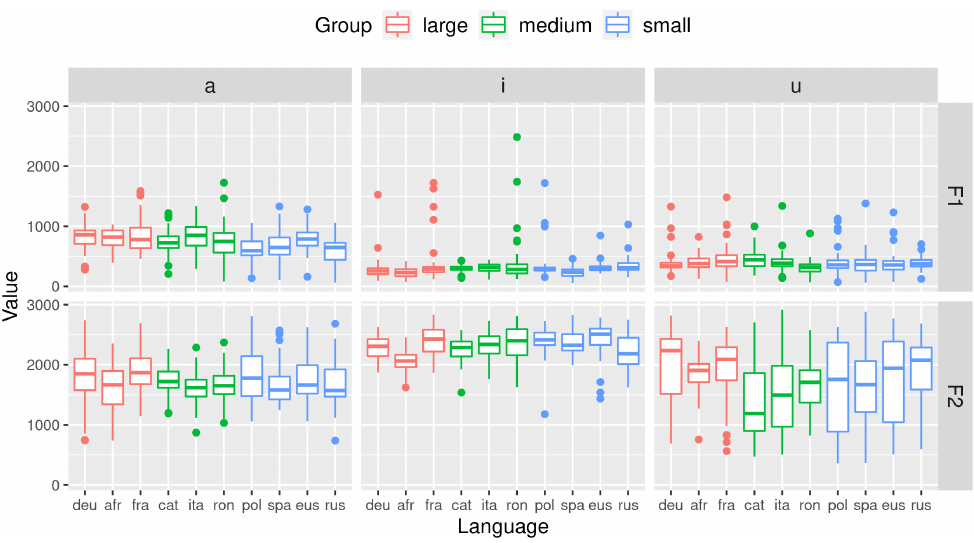
Figure 2. The distribution of formants for [a], [i] and [u] across the 10 languages of the data set. The languages on the x-axis are ranked according to their number of timbres from high to low. The colors indicate the group to which the language is affiliated with in terms of number of timbres: red = large, green = medium, blue = small.